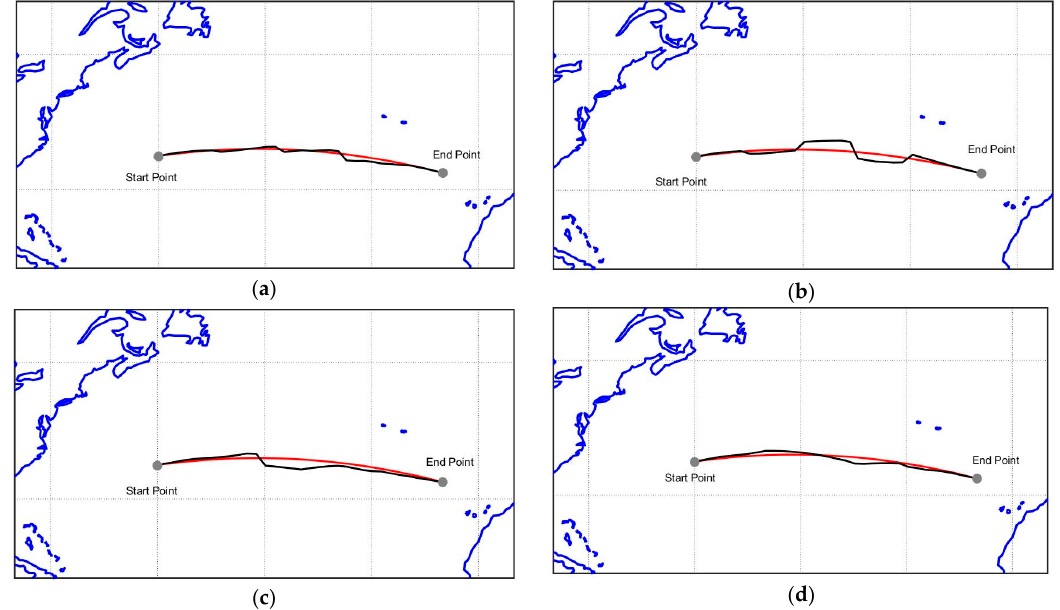
Figure 7. Minimum distance (great circle) and optimal route detection, F N = 0.21: ( a ) Case 1; ( b ) Case 2; ( c ) Case 3; ( d ) Case 4.